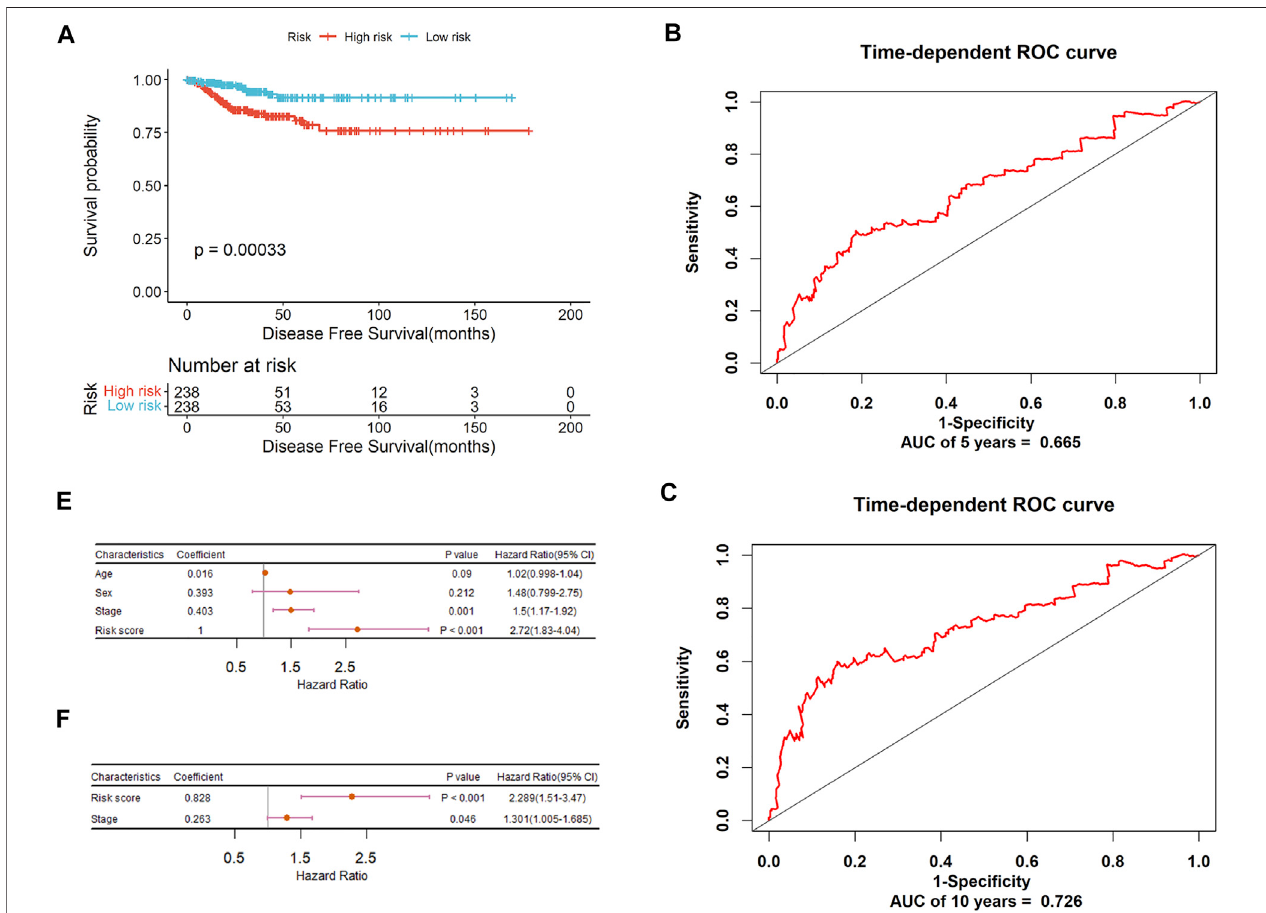
FIGURE 8 | The prognostic signi fi cance of PTC-m3 signature to predict DFS of PTC patients. (A) Kaplan-Meier curve analysis for DFS. (B) ROC validation of prognosticvalueofPTC-m3signatureforpredicting5-yearssurvivalofPTCpatients. (C) ROCvalidationofprognosticvalueofPTC-m3signatureforpredicting10-years survival ofPTC patients. (D) Forest plot summary ofunivariable analysis ofsex, age, stage, and riskscore. (E) Forest plot summary ofmultivariable analysis of stage and risk score.